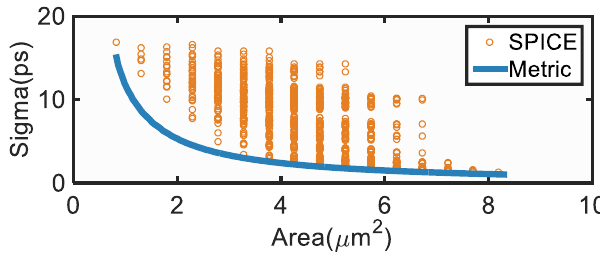
Figure 5. Fine metric validation with SPICE using the logic path in Figure